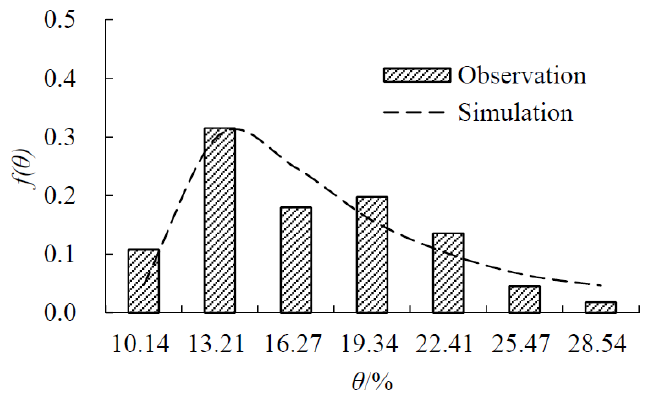
Figure 9. Probability distribution of observed and simulated θ in validation period.